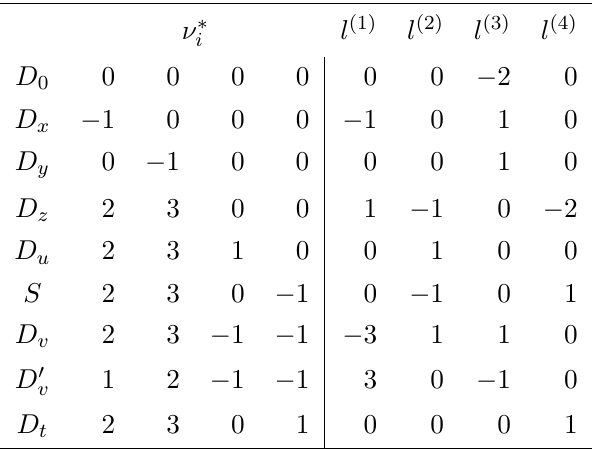
Table 3 . Toric divisors and Mori cone generators of the toric variety whose anti-canonical divi- sor is the compact embedding of the E-string geometry with one (cid:13)avor mass turned on breaking SU(2) (cid:26) E 8 .